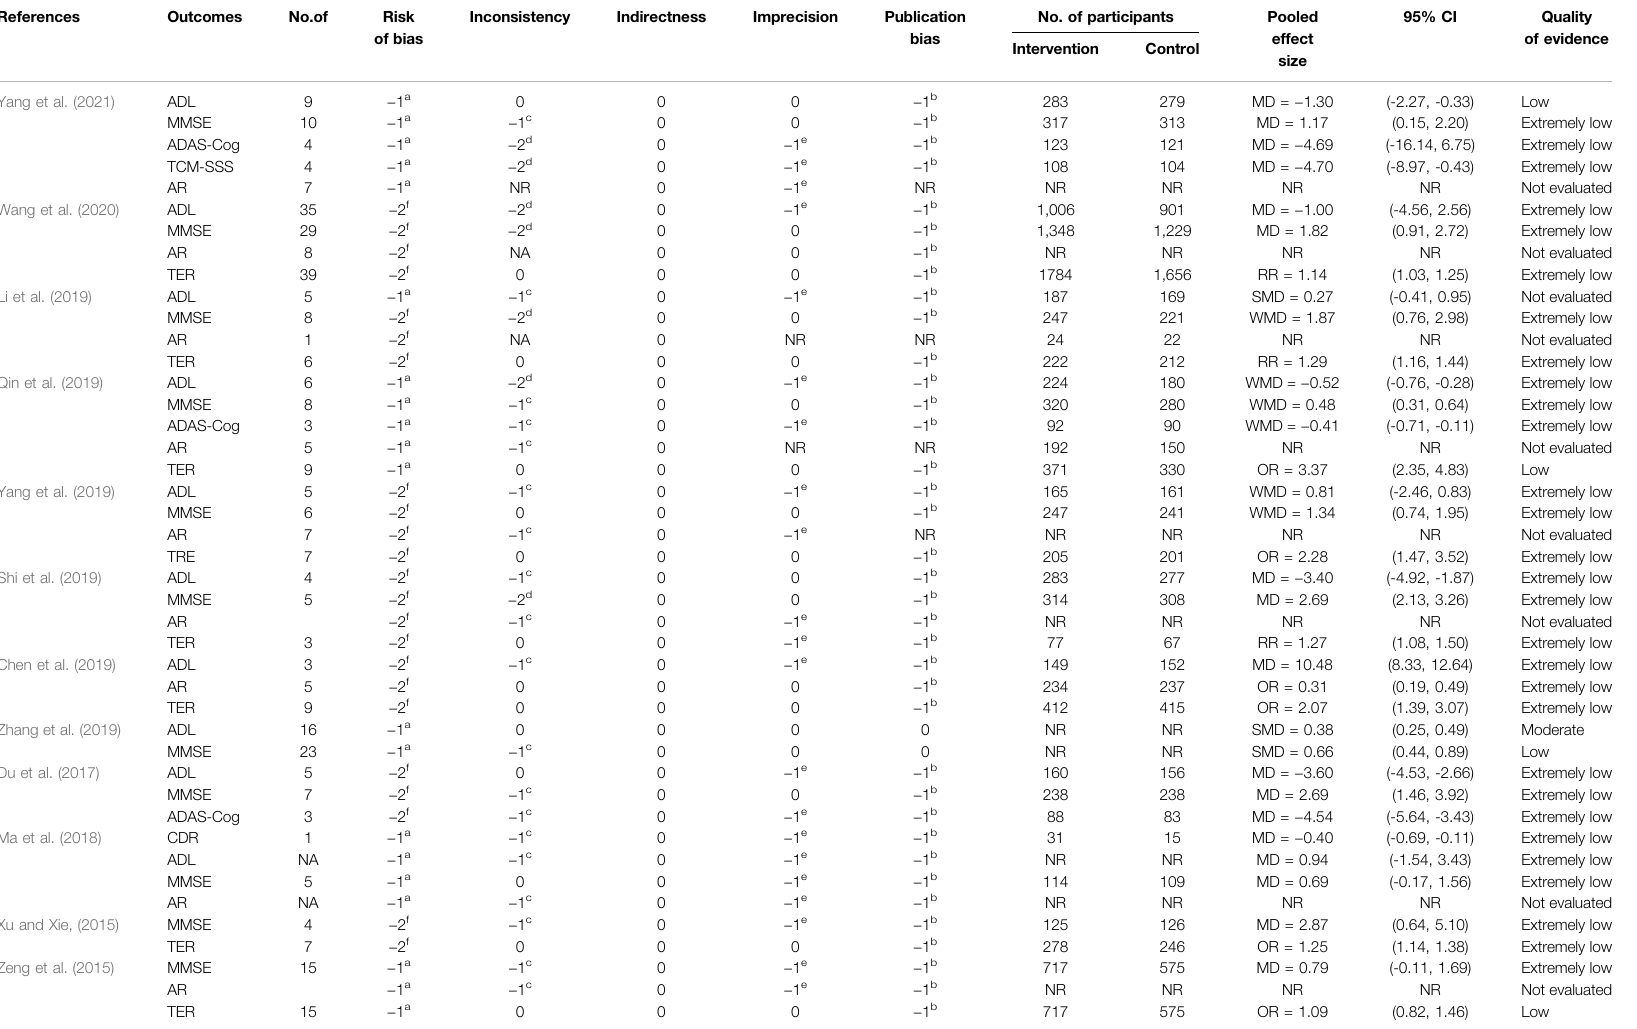
TABLE 2 | Quality of evidence in the included systematic reviews based on